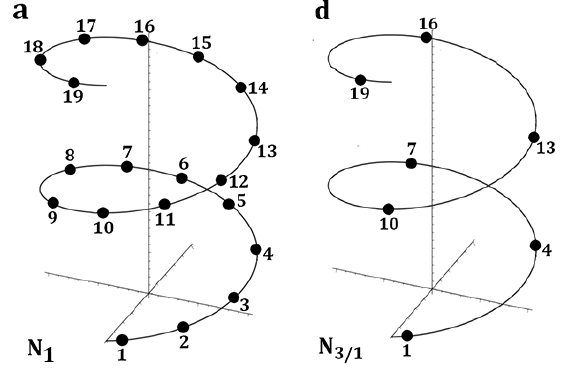
Fig. 3. Schematic representations of a single-stranded DNA and one od the examples of epi-chains of nucleotides; a , the sequence N 1 of numerated nucleotides of the DNA strand; d , the epi-chain of the third order N 3/1 , which contains nucleotides with numbers 1-4-7-10-…